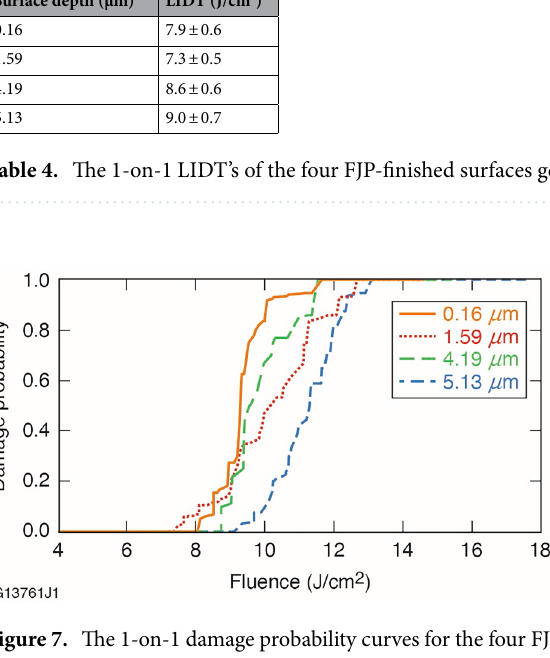
Figure 7. The 1-on-1 damage probability curves for the four FJP-finished